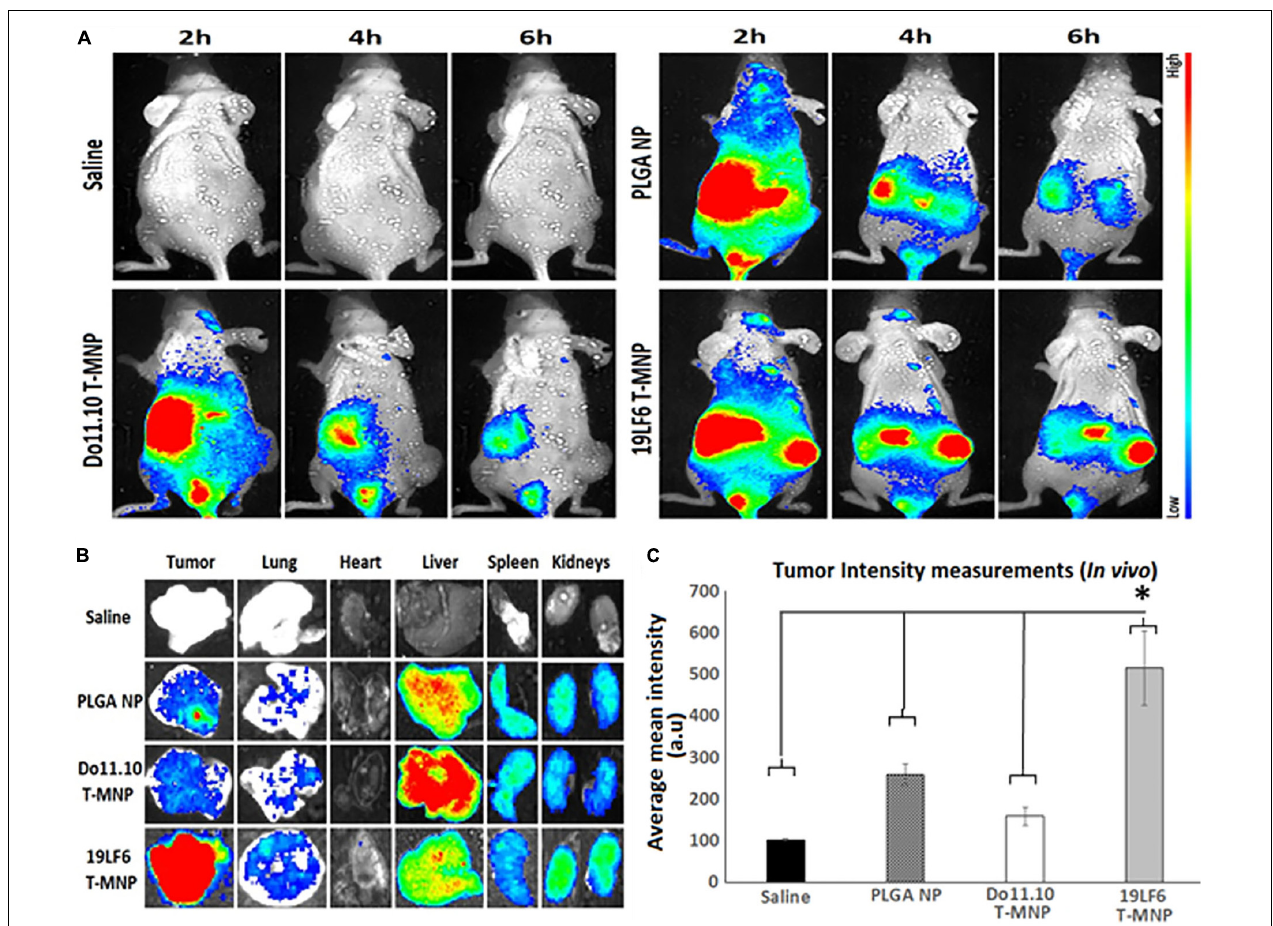
FIGURE 6 | In vivo and ex vivo analysis of T-MNP biodistribution. (A) Real-time tumor targeting characteristics of IV injected NPs on melanoma tumor models. (B) Ex vivo organ images of biodistribution in different study groups. (C) Measured fluorescent intensity of in vivo biodistribution study groups in tissue homogenates ( n = 6 per group). PLGA, poly-lactic- co -glycolic acid; NP, nanoparticle; T-MNPs, T-cell membrane-coated PLGA NPs. D-MNP’s, DO10.11 membrane coated PLGA NPs; C-6, coumarin-6; A-MNP’s, A549 membrane coated PLGA NPs; NNP, naked nanoparticle; OD, optical density; IC, inhibitory concentration; RT-PCR, reverse transcriptase polymerase chain reaction; UV-Vis, ultraviolet visible; MTS, 3-(4,5-dimethylthiazol-2-yl)-5-(3-carboxymethoxyphenyl)-2-(4-sulfophenyl)-2H-tetrazolium. *Statistically significant with P <